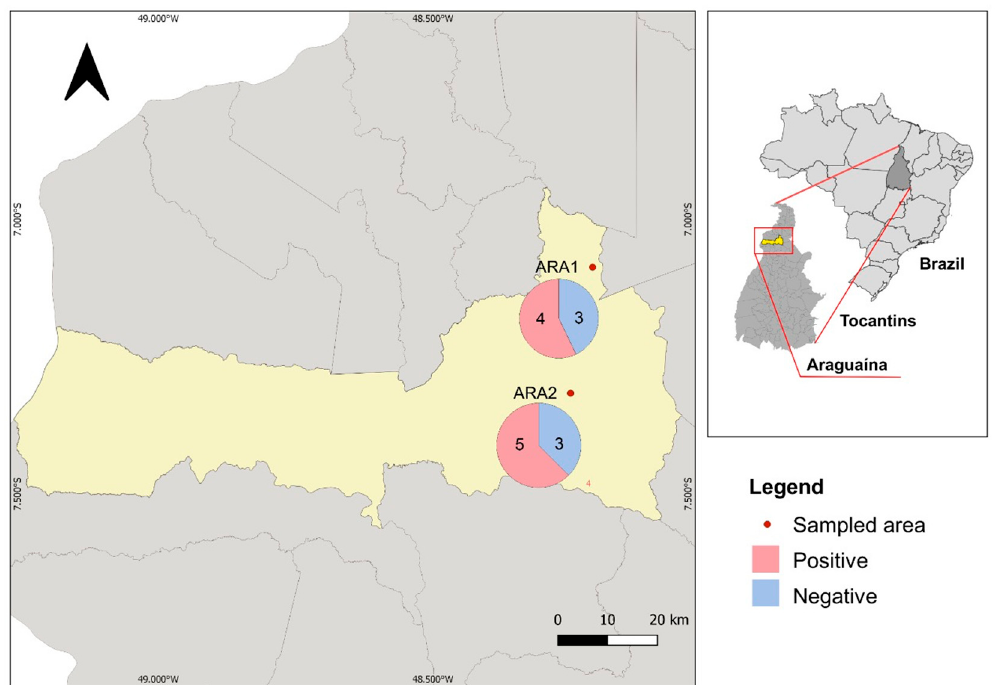
Figure 3. Environmental detection of Paracoccidioides sp. in Araguaína-TO. The location of each sampled area is pointed out on the map, and the number of positive and negative samples for the nested PCR assay are represented in a pie chart next to each sampled location.